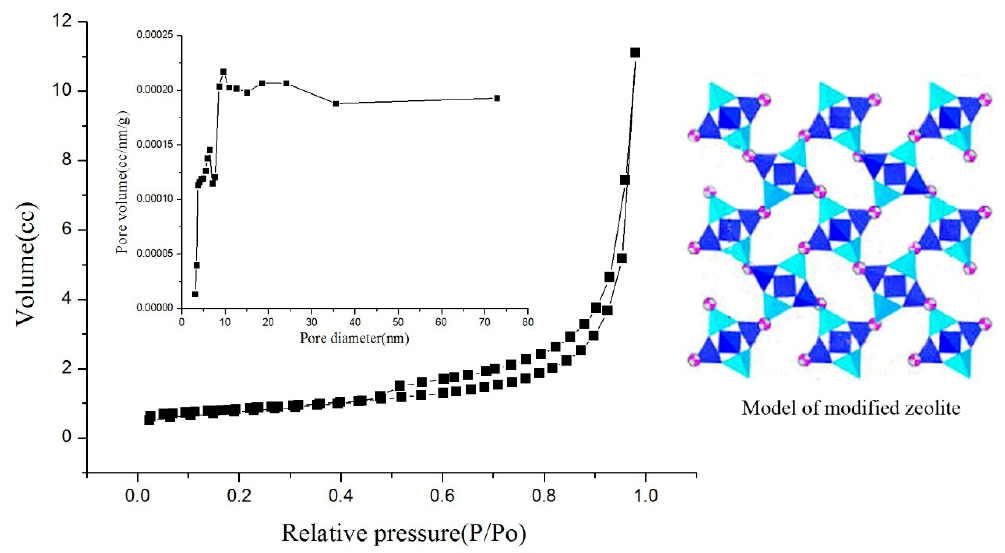
Figure 5. N 2 adsorption–desorption isotherms and pore size distribution of MZ.